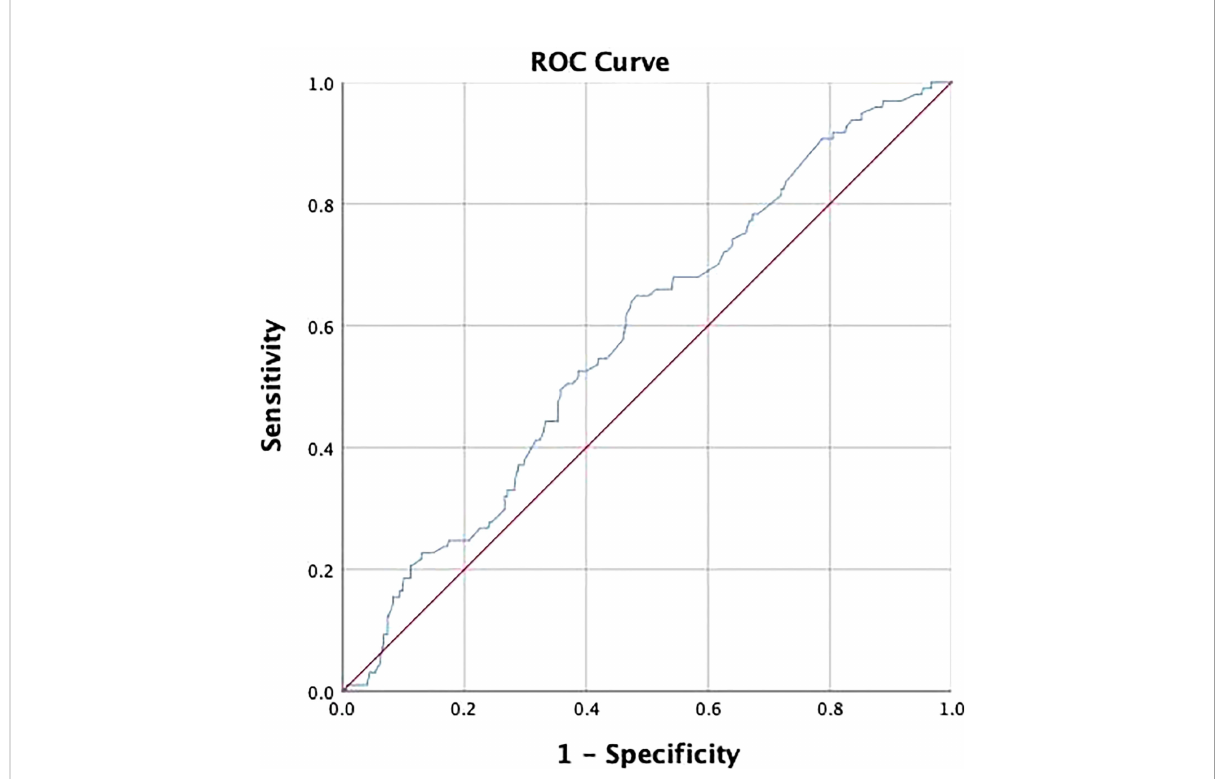
FIGURE 2 Receiver operating characteristic (ROC) curve was used to determine the cut-off value of lesion size and assess its discriminative power. The cut-off value was 3.25 and the area under the curve (AUC) was 0.583 (P =